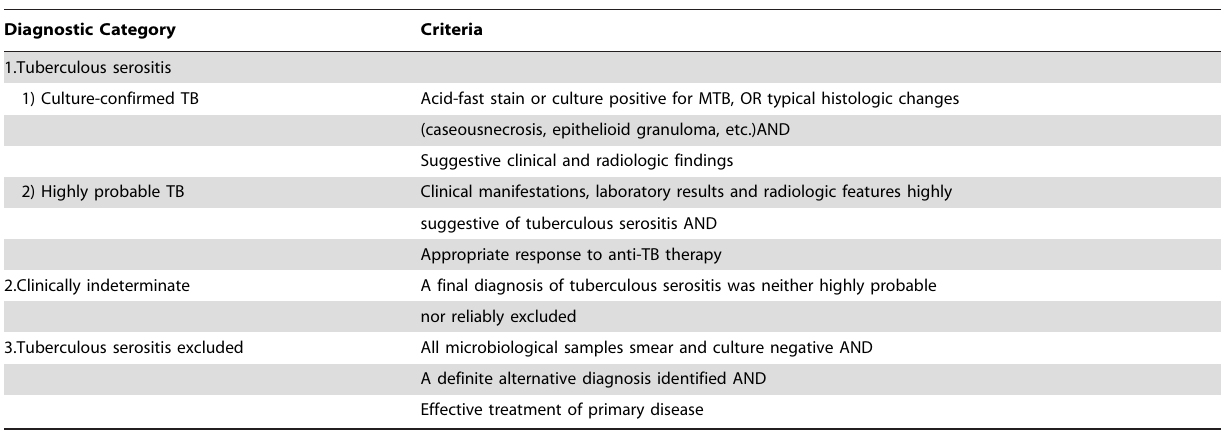
Table 1. Categorization of the Study Population.